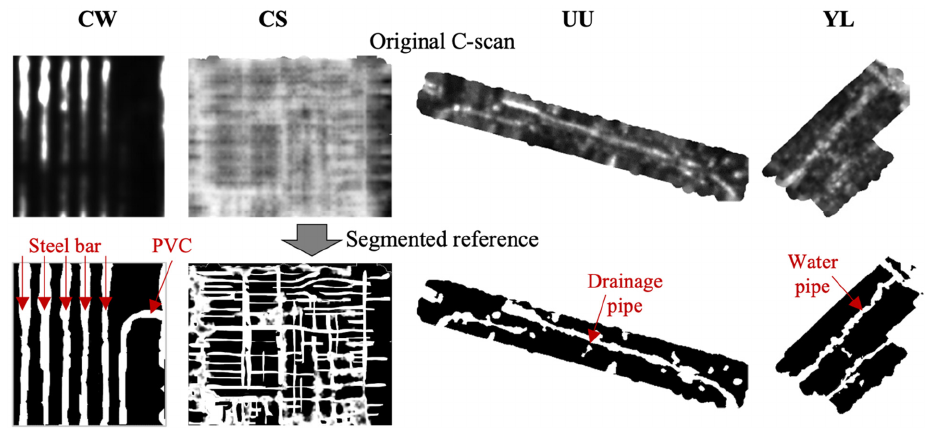
Figure 5. Original C-scans and segmented reference images of four representative cases named CW, CS, UU, and YL.